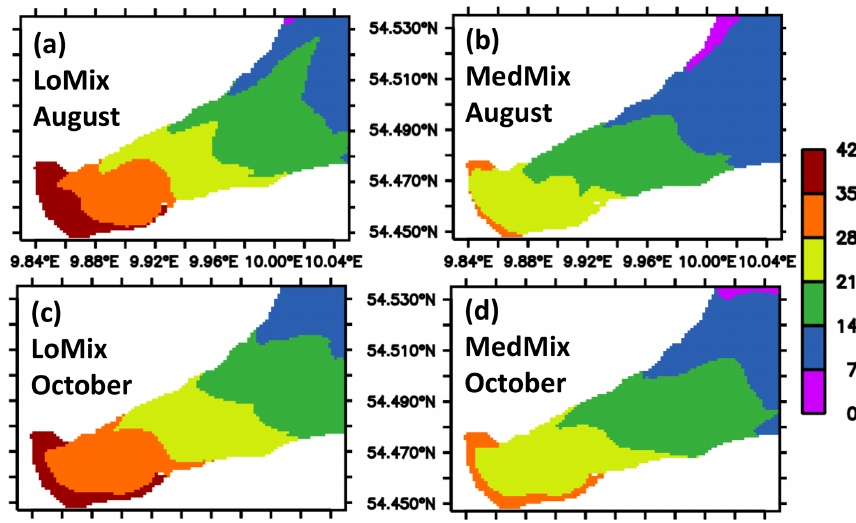
Figure 7. Simulated climatological estimate of the residence time of water parcels in EB. The units are days elapsed since the water flushed into the bight. The estimate refers to the longest residence time found in local water columns. Panels (a) and (b) refer to August calculated by the simulations LoMix and MedMix , respectively. Panels (c) and (d) refer to October calculated by the simulations LoMix and MedMix , respectively. Note that the model domain extends beyond the eastern boundary shown here (see also Fig. 2).